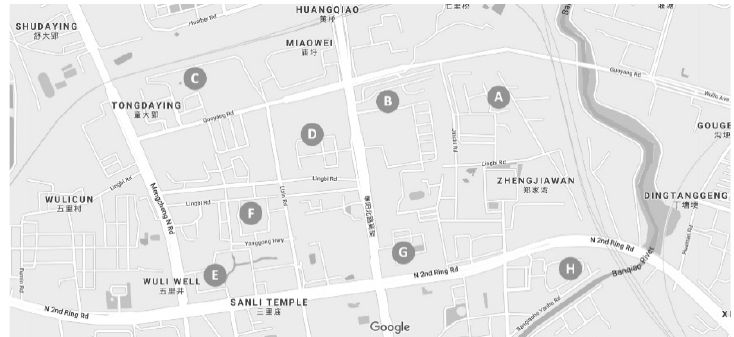
Figure 4. The position of Luyang District.